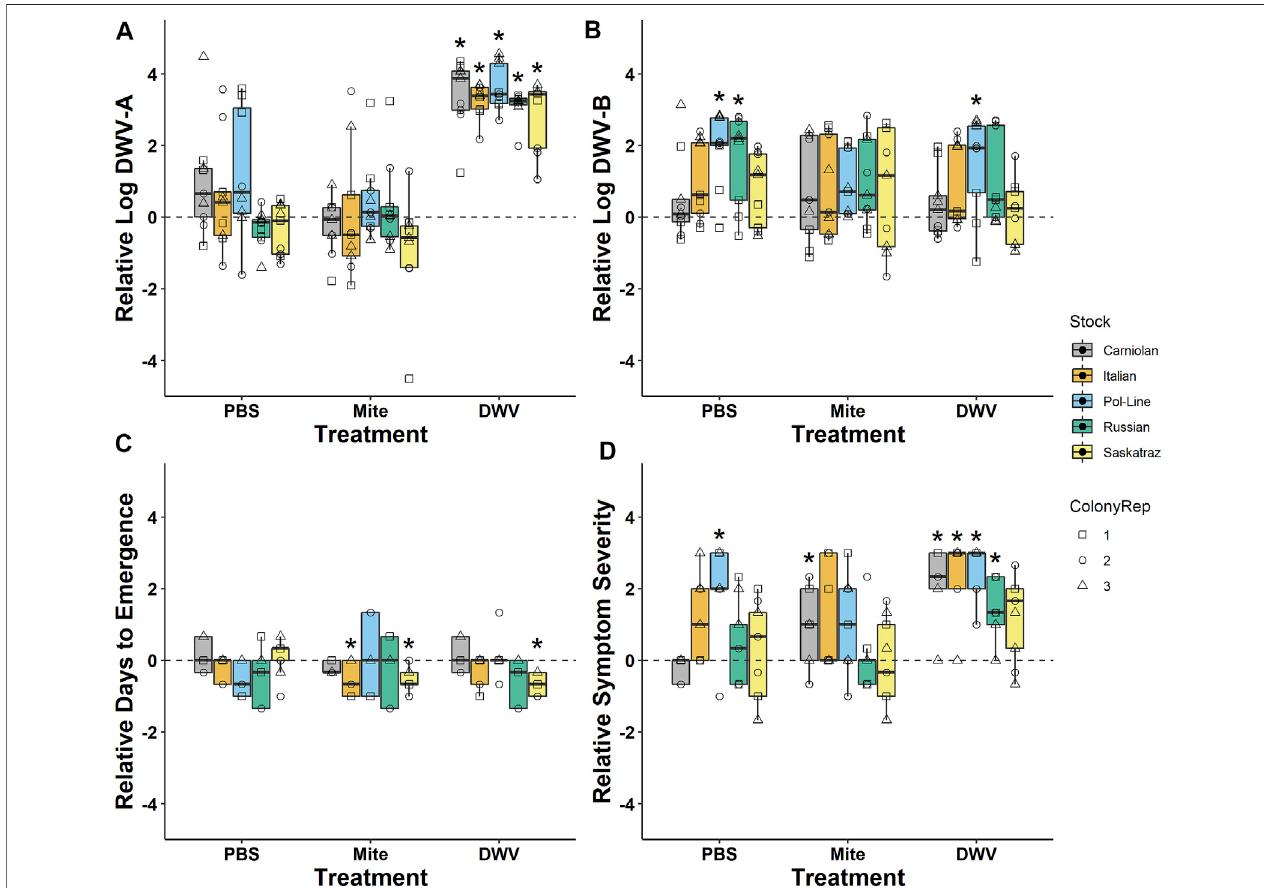
FIGURE 2 | Treatment values relative to naturally occurring levels. Comparison of (A) log-transformed DWV-A and (B) DWV-B levels in head tissues indicates that the pupae DWV injection treatment sourced from symptomatic adults successfully increased DWV-A but not DWV-B levels in all bee stocks. (C) Treatment × bee stock interactions decreased the number of days from pupal treatment until adult emergence compared to the control. (D) DWV symptom severity generally increased in the DWVtreatmentbutinteractedwithbeestock. Valuesweremade relative totheuntreated controlbeesfrom thesame colonywithnaturally occurringinfections